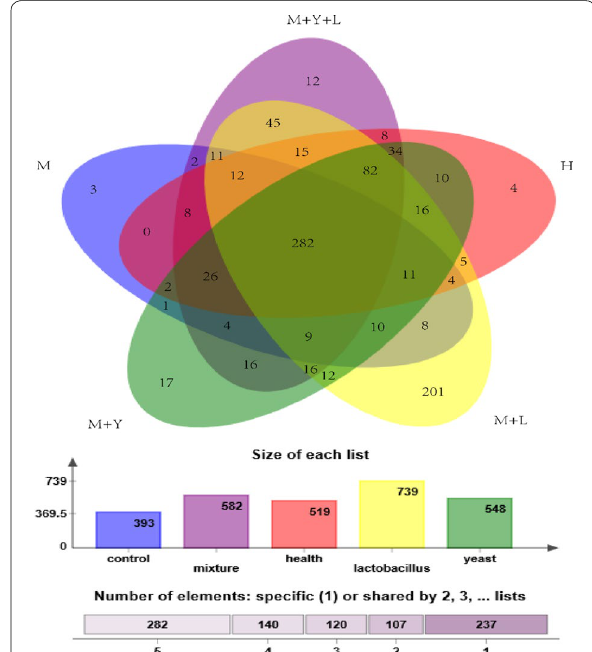
Fig. 1 Venn diagram of OUTs from different